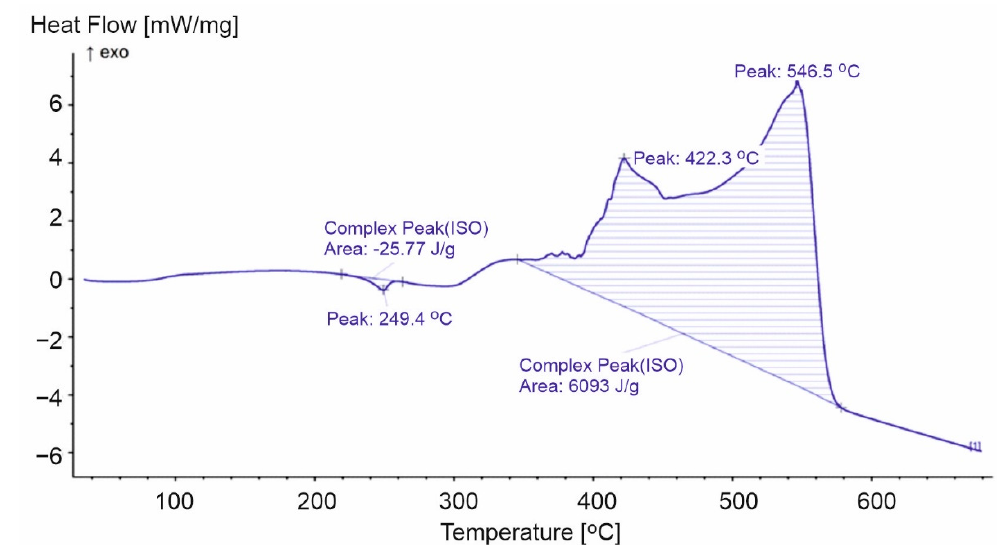
Figure 11. DSC curve for PET ‐ 1.